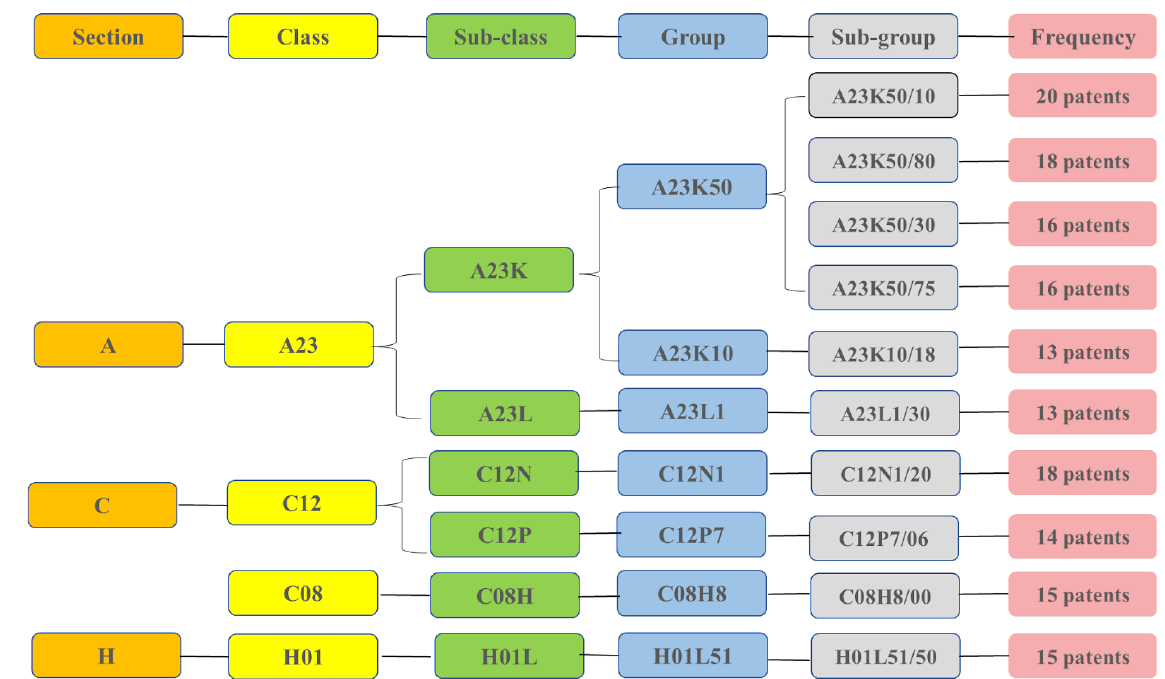
Figure 2. Top 10 number of patents filed on the participation of family farming in the development of new food products, according to their IPC codes.